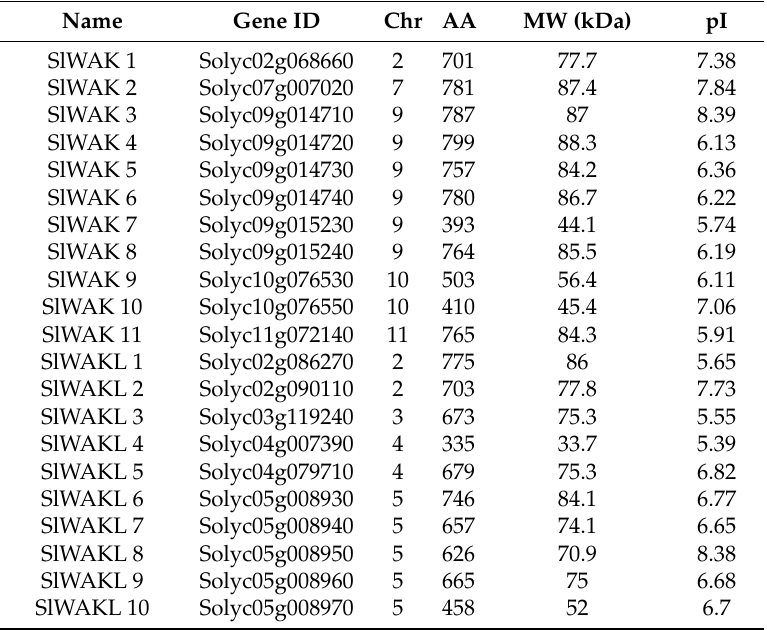
Table 1. The characteristics of SlWAK-RLKs in